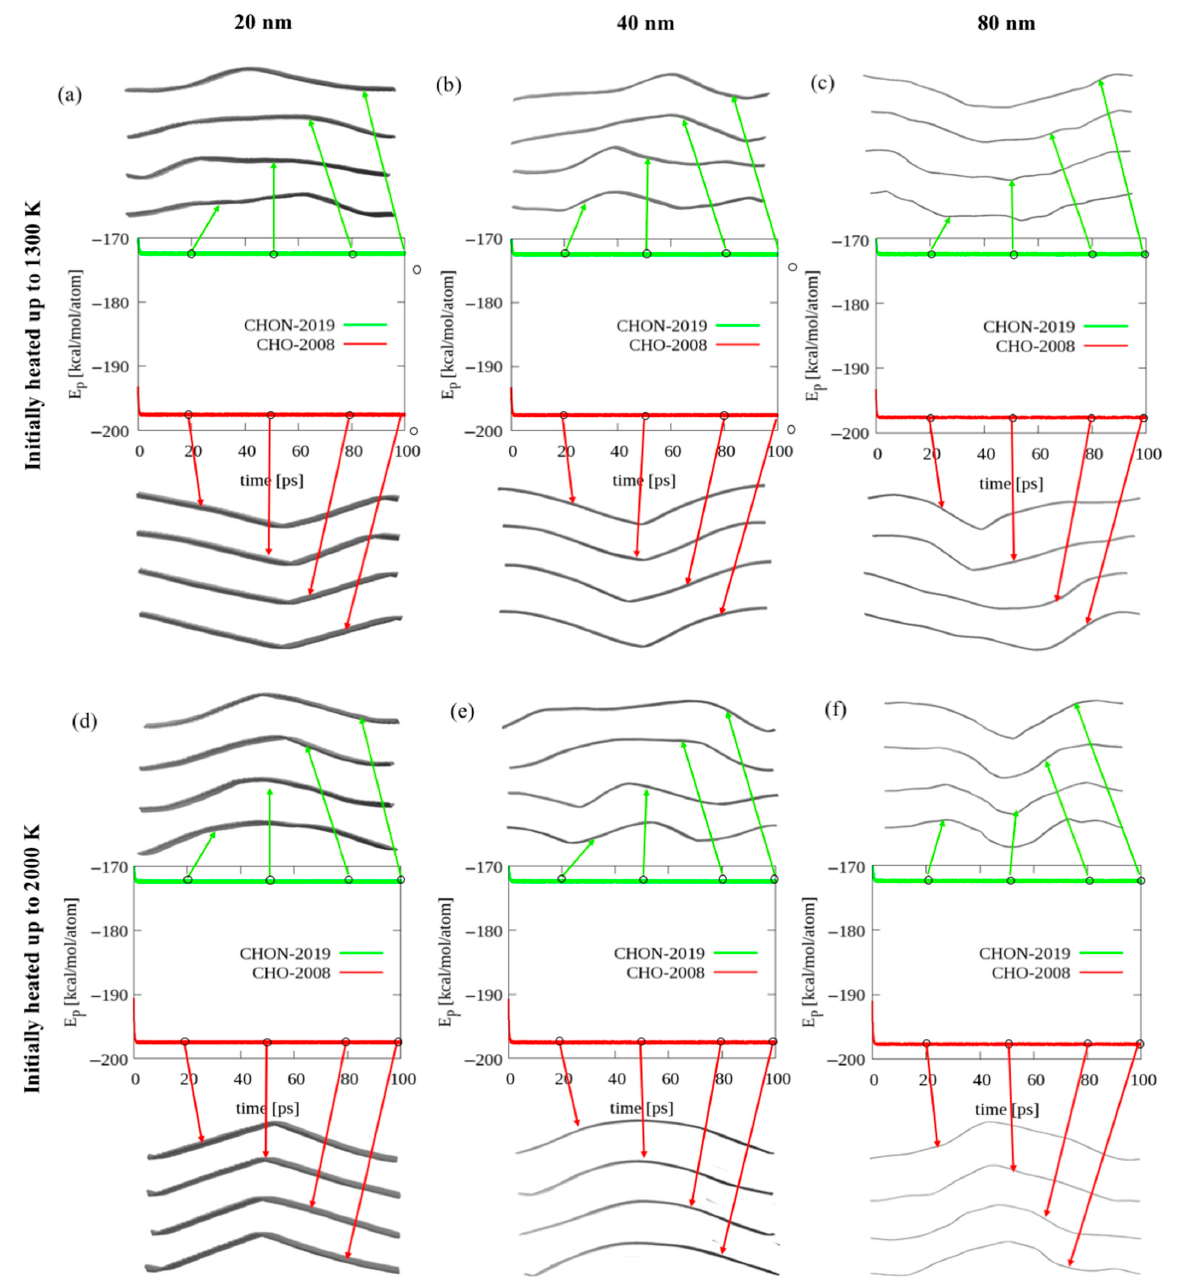
Figure 2. The graphene ribbon geometries and their corresponding potential energies. Comparison of simulation snap- Scheme 20. 40, and 80 nm) after initial heating to 1300 K ( a – c ), or 2000 K ( d – f ), followed by annealing at 77 K for 100 ps using a number of atoms, volume, and temperature (NVT) ensemble. The middle panel shows a comparison of the time evolution of the potential energy for the corresponding graphene ribbons using the CHON-2019 (green) and CHO-2008 (red) ReaxFF parameter sets.